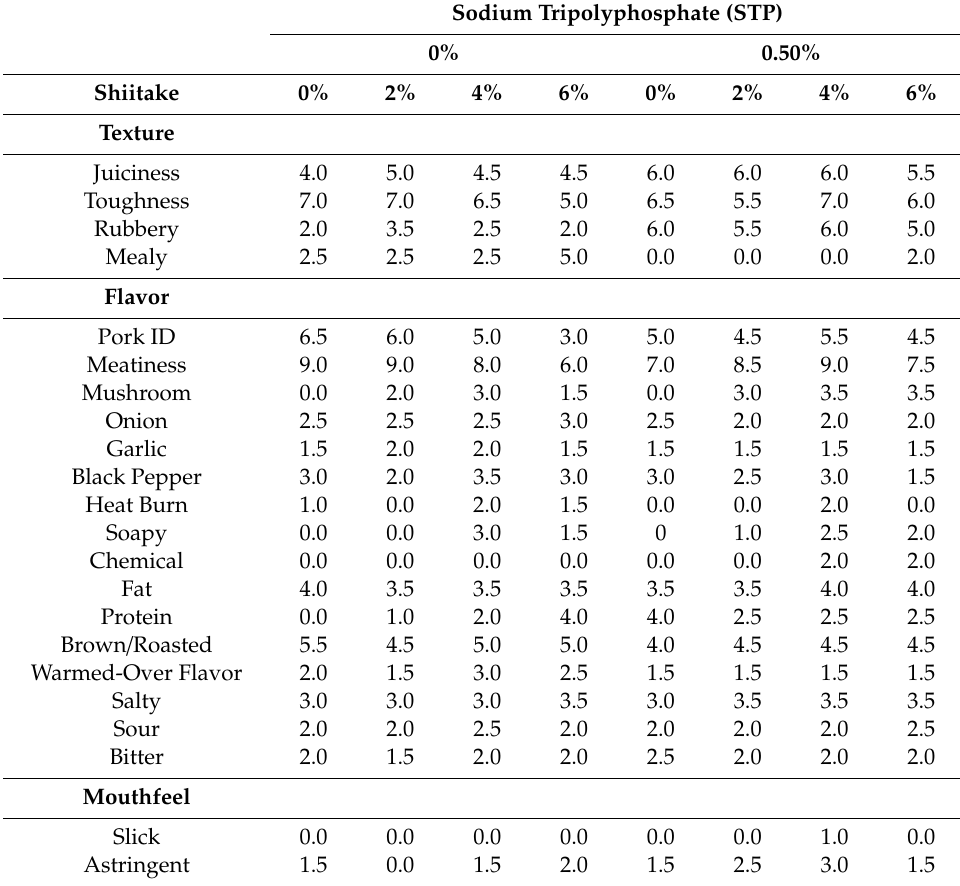
Table 4. Flavor and texture profile scores for pork patties with varied percentages of shiitake mushroom powder with and without phosphate, and with 48 h storage.